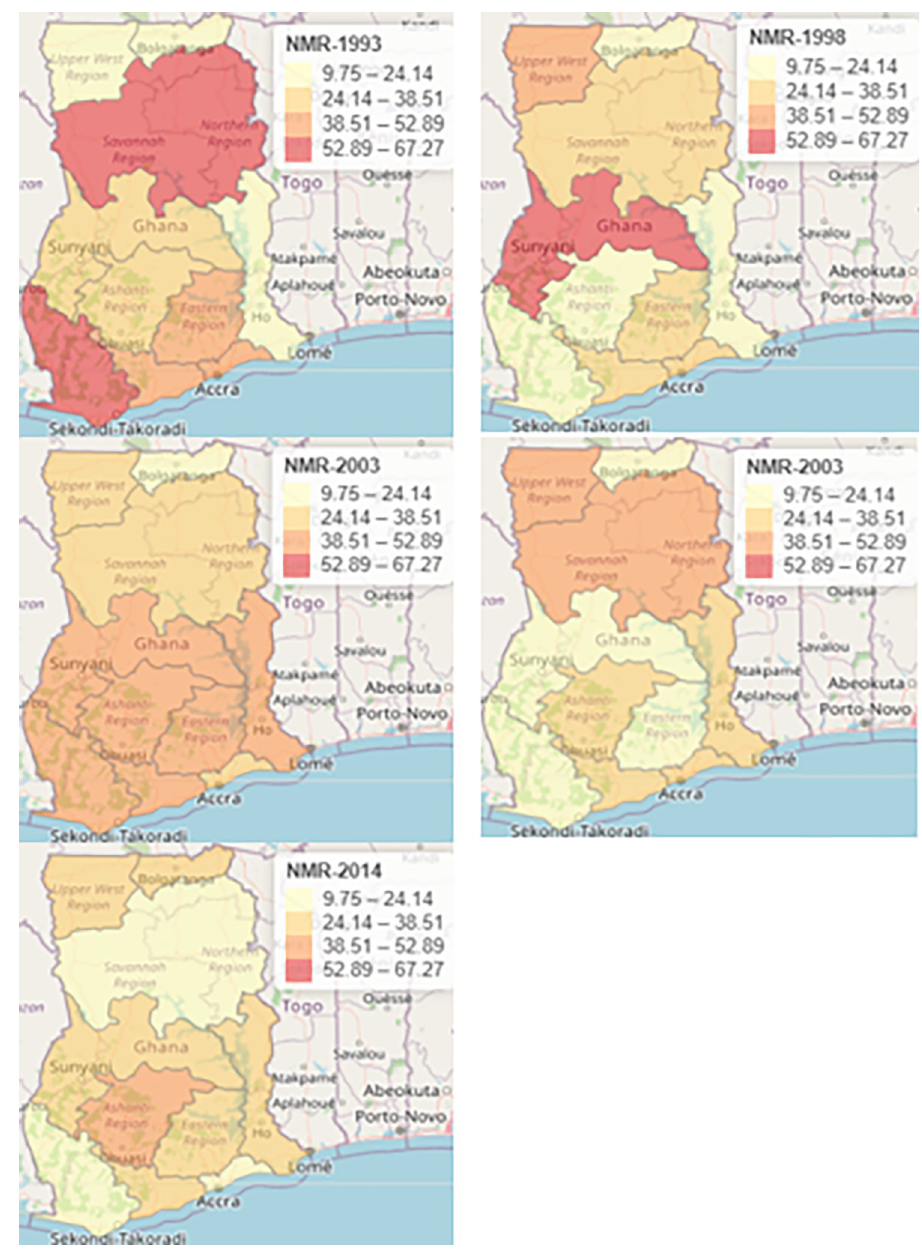
Fig 2. Map displaying weighted neonatal mortality rates for the ten regions in Ghana, 1993–2014. Note: This map was produced by the authors. baby estimated from the Bayesian Hierarchical Spatiotemporal model indicated a marginal increase in the risk of neonatal deaths [PM: 0.003 ((95% 0.00,0.01)] with an estimated relative risk of 1.003 [exp(0.003)]. All geographical factors in model 2 were not significant. With reference to model 2, there was spatial dependence or spatial autocorrelation in the neonatal mortality because the 95% credible interval associated with the posterior mean of the precision of structured spatial random effect (CAR) t (cid:0) 1 shows some spatial dependence [Pos- m terior Mean: 21761.19 (95% CrI: 1833.40, 79892.70)]. The posterior mean of t (cid:0) 1 [Posterior u